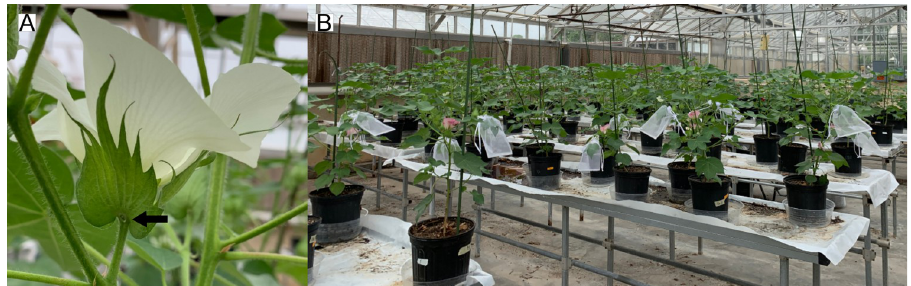
Fig 1. Bracteal EF nectary of G . hirsutum and the greenhouse during experimentation. (A) G . hirsutum flower on the day of anthesis. A droplet of nectar can be seen produced by the bracteal EF nectary at the base of one of the three leaf-like bracts that surround the reproductive structure. (B) Plants in the foreground with leaves covered by white organza bags are being exposed to herbivory while plants in the background have not yet reached the day of anthesis for the first flower.